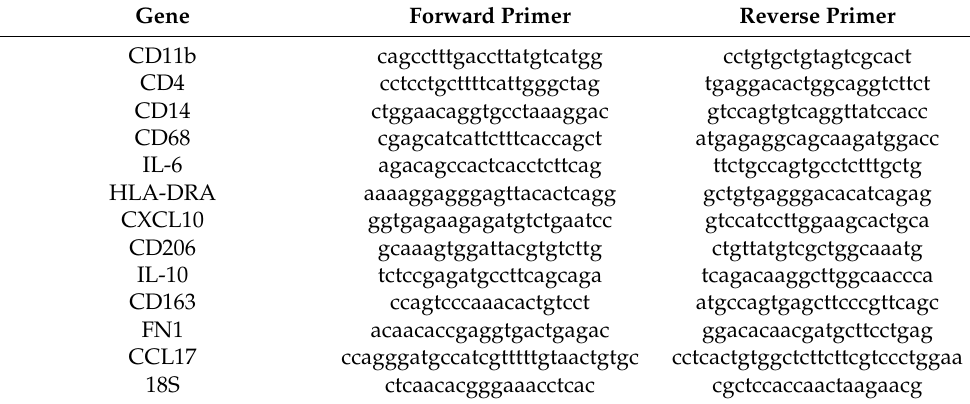
Table 1. Sequences of primers